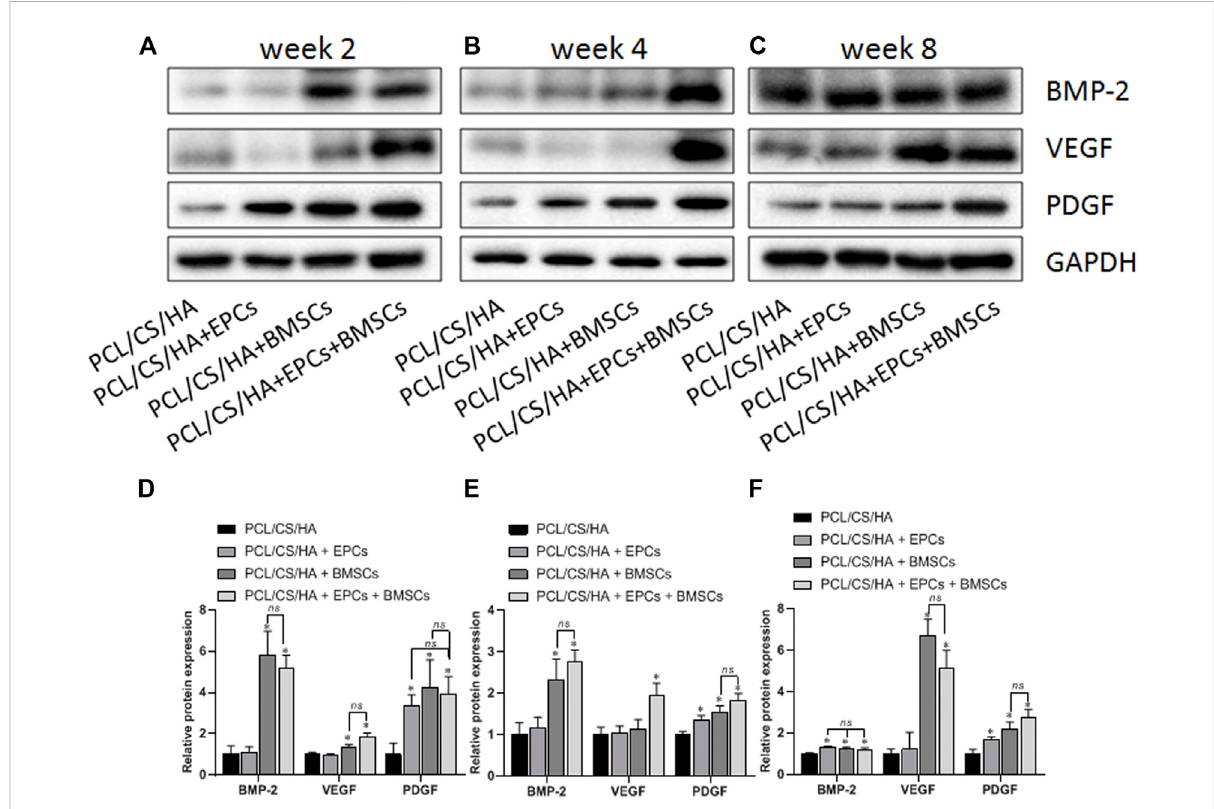
FIGURE 10 Expression levelsofBMP-2,VEGF,andPDGFintherepairedcalvariawithcompositescaffold bywesternblotanalysis.Therepresentativebands andthequanti fi edgrayscalenormalizedtoGAPDHforBMP-2,VEGF,andPDGFexpressionatthe2ndweek (A,D) ,4thweek (B,E) ,and8thweek (C,F) . * p < 0.05 vs. HA/CS/PCL group, ns p >